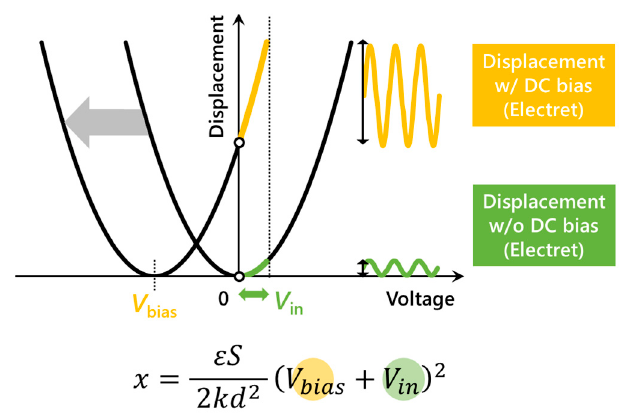
Figure 1. Displacement of MEMS electrostatic actuator augmented by DC biasing from electrets replacing external voltage sources.